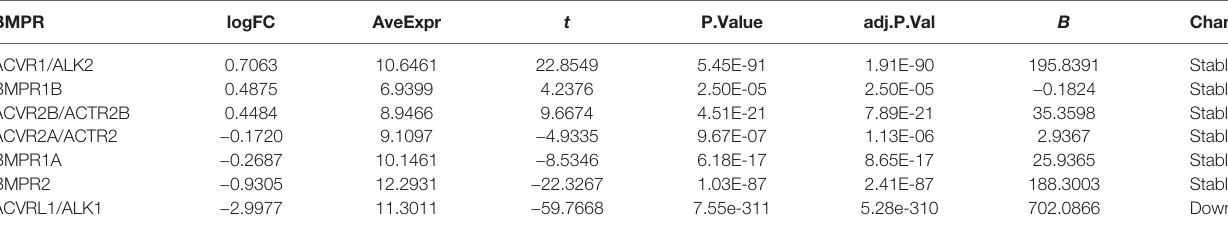
TABLE 2 | The differential expression of seven BMPRs in lung